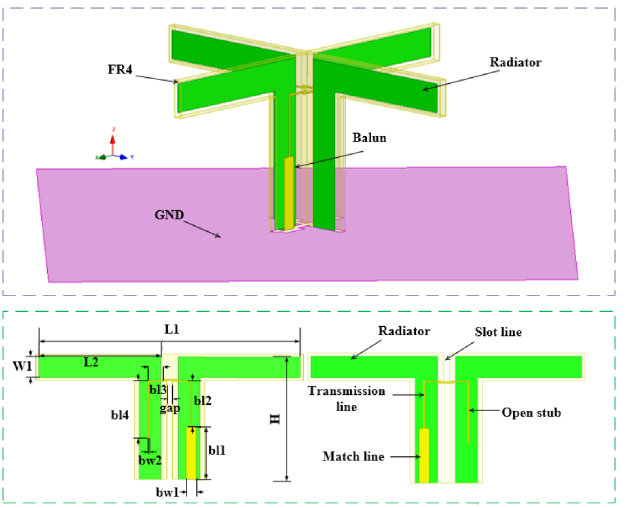
Fig. 1. Geometry of dual-polarized dipole and single-polarized dipole.